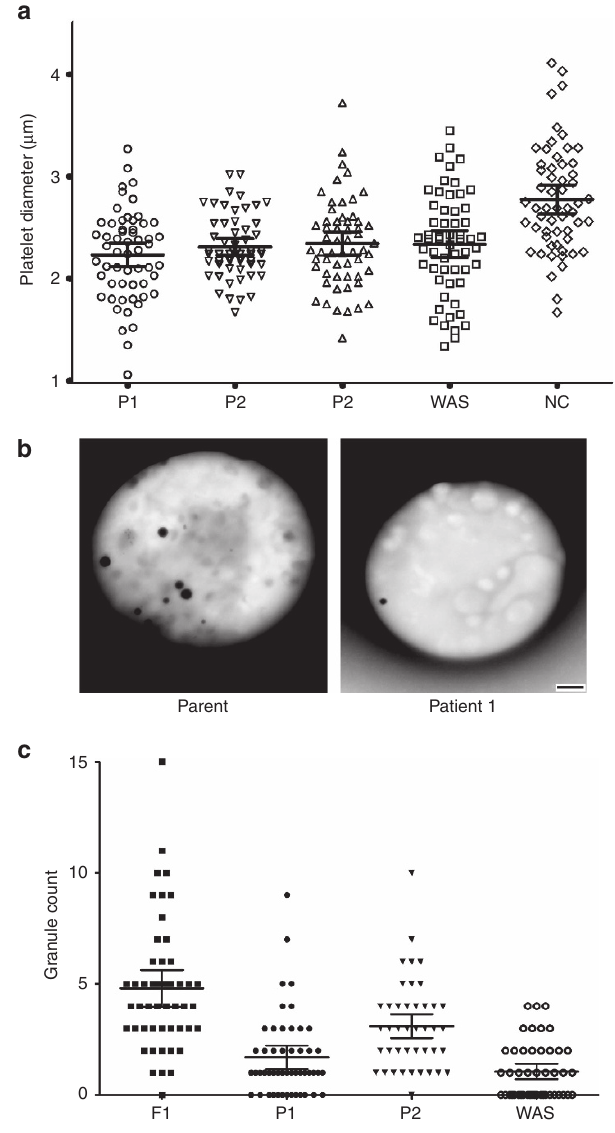
Figure 5 | ARPC1B-deficient platelets are microthrombocytes containing decreased numbers of dense granules. ( a ) A comparison of platelet circumferential ring diameter distributions for all three ARPC1B mutant patients (P1, P2, P3) and a WASP-null patient (WAS) shows that all are significantly smaller (that is, microthrombocytes) compared to platelets from a normal donor (NC; P o 0.0001, unpaired t -test; n ¼ 57 platelets, means and 95% confidence intervals shown by bars). No significant differences were observed among patients. ( b ) TEM of platelet whole mounts from an unaffected parent (left) and Patient 1 (right), showing dense granules detectable as dark spots (bar ¼ 500nm; (cid:3) 25,000). ( c ) Dense granule counts derived from whole-mount TEM imaging of platelets from Patient 1 (P1), Patient 2 (P2) and a WASP-null patient (WAS) were significantly lower than for cells from an unaffected relative (F1); Mann–Whitney test P o 0.0008, n ¼ 50 platelets. Means for Patient 1 and WASP null were not significantly different ( P ¼ 0.07), while the mean for Patient 2 was significantly higher than for Patient 1 ( P o 0.0001). Means and 95% confidence intervals shown by